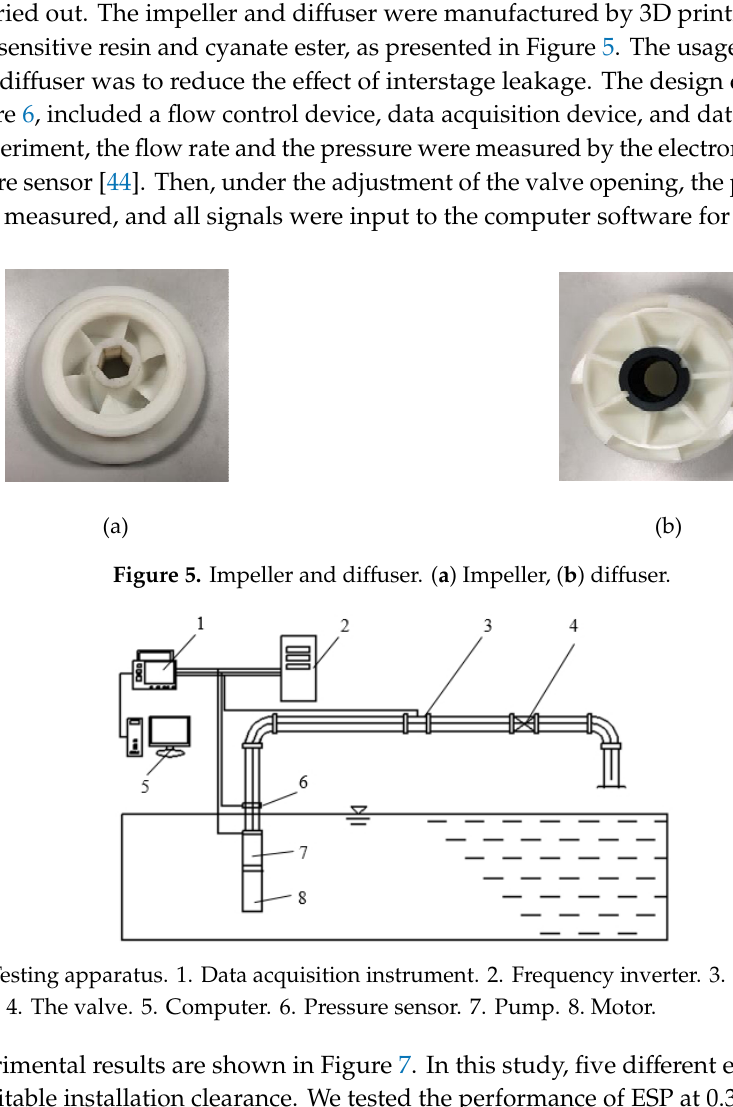
Figure 7. Comparison of pump performance between numerical and experimental results. 3.2. Performance Analysis Numerical simulations were carried out at five flux (0.6 Q d , 0.8 Q d , 1.0 Q d , 1.2 Q d , 1.4 Q d ) for different end clearances (b = 0.1 mm, 0.3 mm, 0.6 mm, 0.9 mm, 1.2 mm). Figure 8 shows the CFD results of the performance of the ESP at different end clearances. It can be seen that as the flow rate